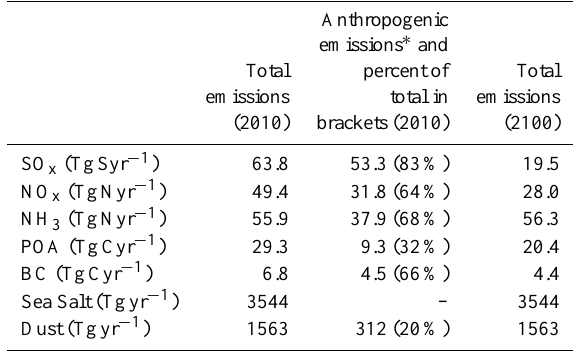
Table 1. Annual global aerosol or aerosol precursor emissions for used in